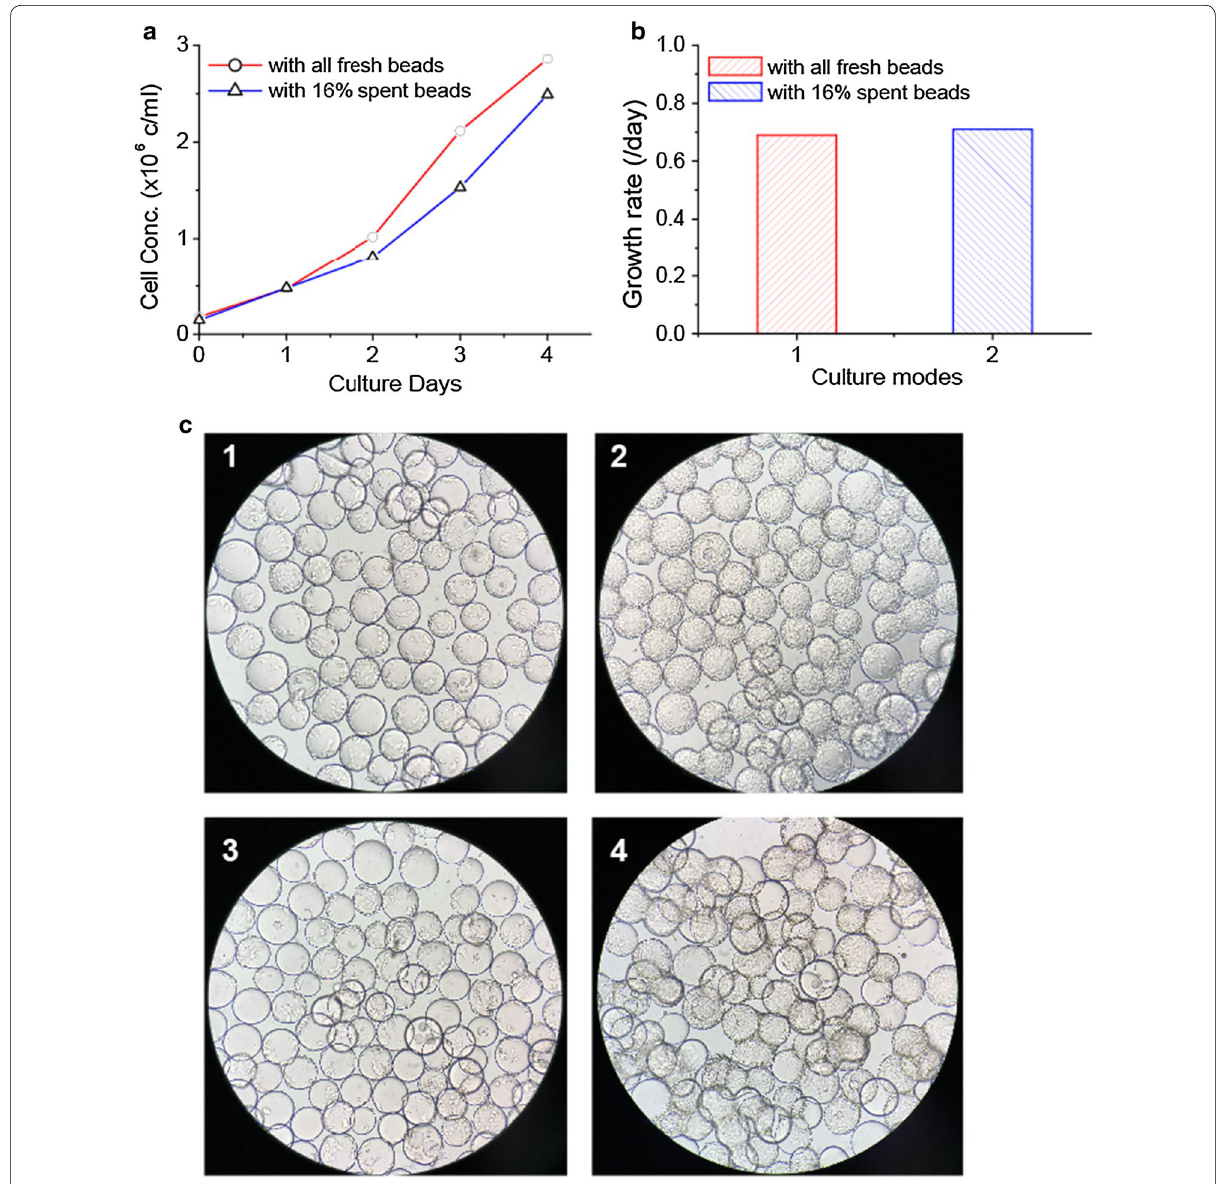
Fig. 4 Effects of fresh microcarriers and partial spent microcarriers on cell growth. a Vero cell growth curves in all fresh microcarriers and partial spent microcarriers. b Vero cell growth rate comparison in previously described conditions above. c HEK293T cell growth pictures. Images 1 and 2 (above) are day 1 and day 3 of HEK293T cell growth on all fresh microcarriers. Images 3, 4 (above) are day 1 and day 3 of HEK293T cell growth on partial spent